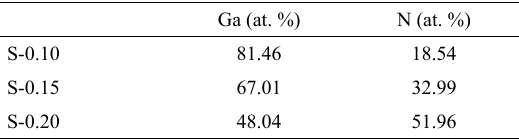
Table 3. Atomic concentration of Ga and N, determined by EDS, in samples S-0.10, S-0.15 and S-0.20 Ga (at. %) N (at. %)